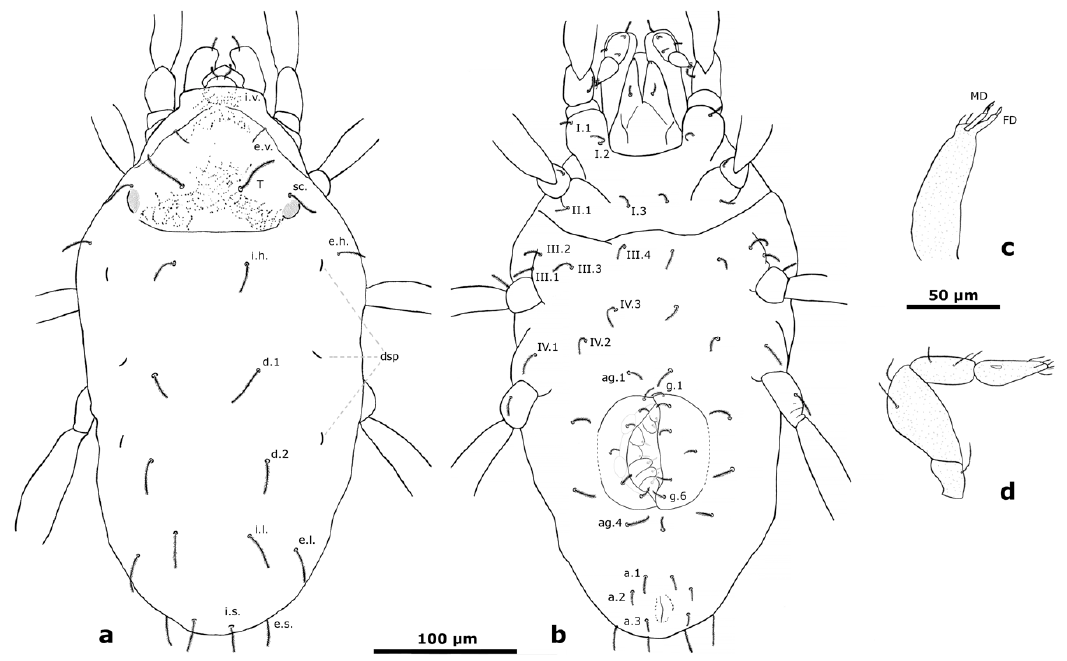
Figure 1. Stereotydeus ineffabilis sp. nov. ( a ) Dorsal view; ( b ) ventral view; ( c ) chelicera and ( d ) lateral view of the pedipalp. Dorso-lateral slit pores (dsp); movable digit (MD) and fixed digit (FD) of chelicerae. Names of dorsal setae: internal vertical (i.v.), external vertical (e.v.), trichobothrium (T), scapular (sc.), external humeral (e.h.), internal humeral (i.h.), 1st and 2nd dorsals (d.1, d.2), internal lumbar (i.l.), external lumbar (e.l.), internal sacral (i.s.) and external sacral (e.s.). Names of ventral setae: coxal setae (I-IV), aggenital setae (ag.), genital setae (g.) and anal setae (a.).